Question: Is the quantity shown trending increasing or decreasing?
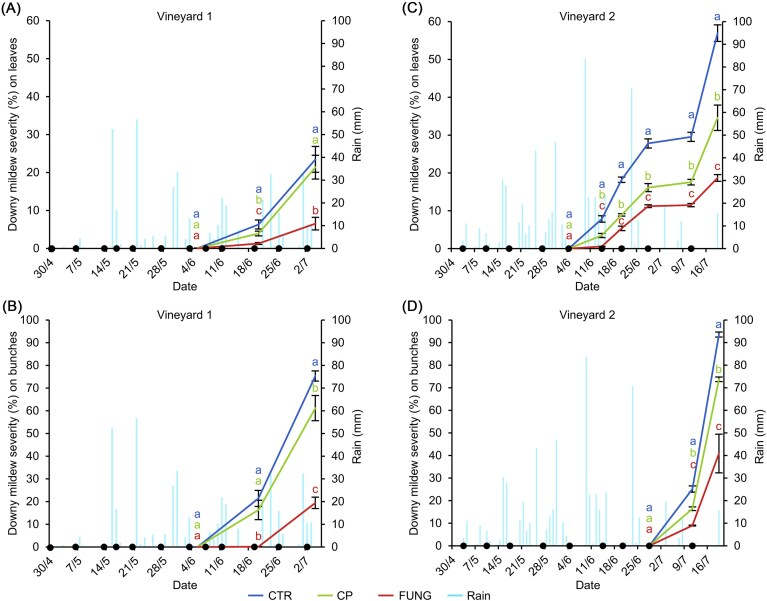
Answer: decreasing